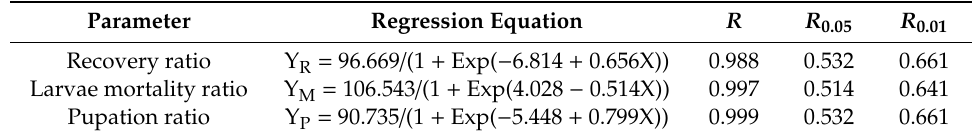
Table 1. Curve equation from a regression between immersed days and recovery ratio of knocked-out larvae within 24 h, larvae mortality ratio, and pupation ratio of larvae of B. minax .